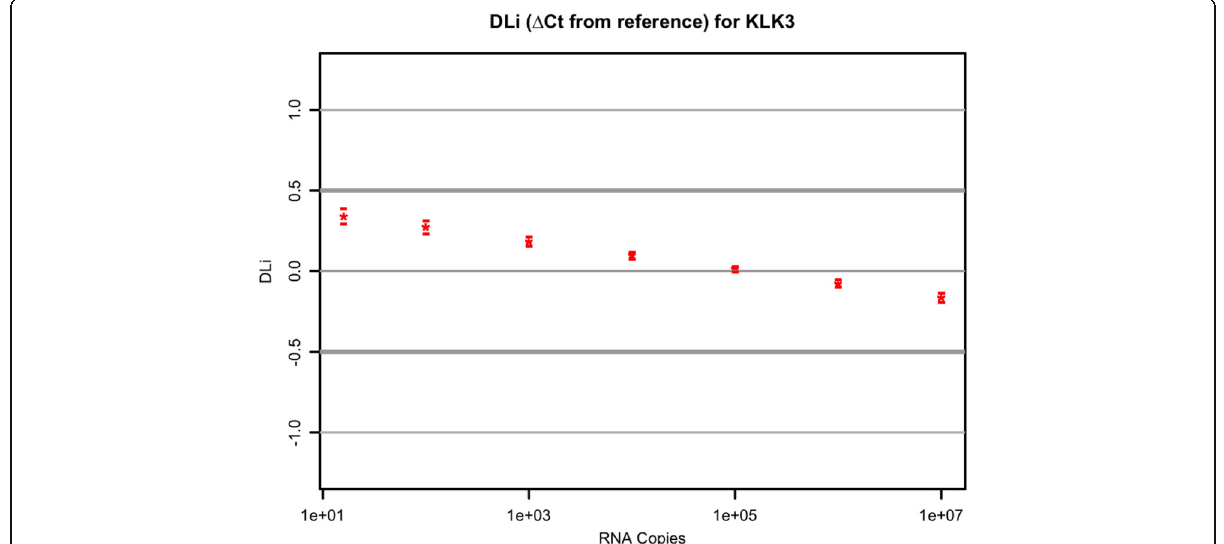
Fig. 1 DLi determined for the KLK3 mRNA assay is illustrated by this plot in which the average DLi (red asterix) and 95% CI are plotted against the RNA concentration for each